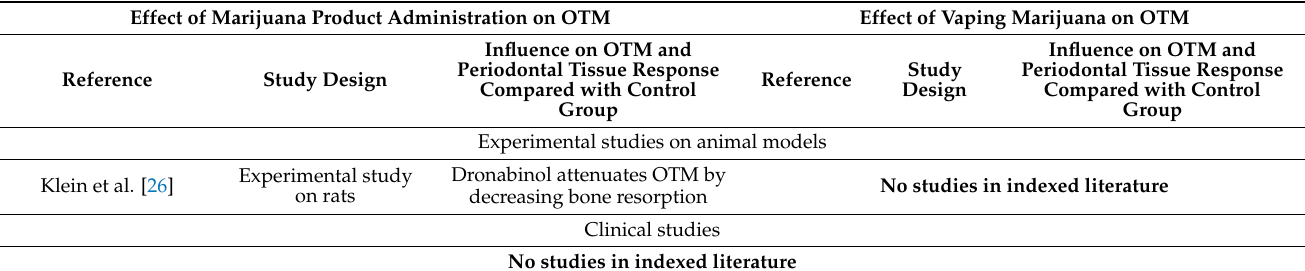
Table 2. Studies evaluating the effects of marijuana product administration and/or marijuana vaping on the rate and biology of orthodontically-induced tooth movement and periodontal tissue response. OTM, orthodontic tooth